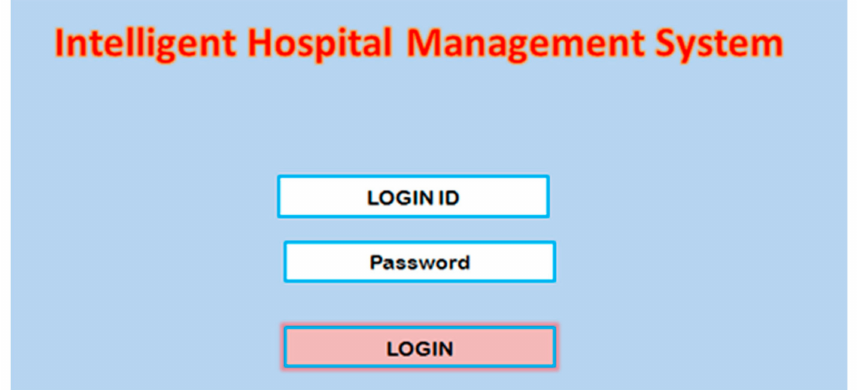
Figure 1. Login module.